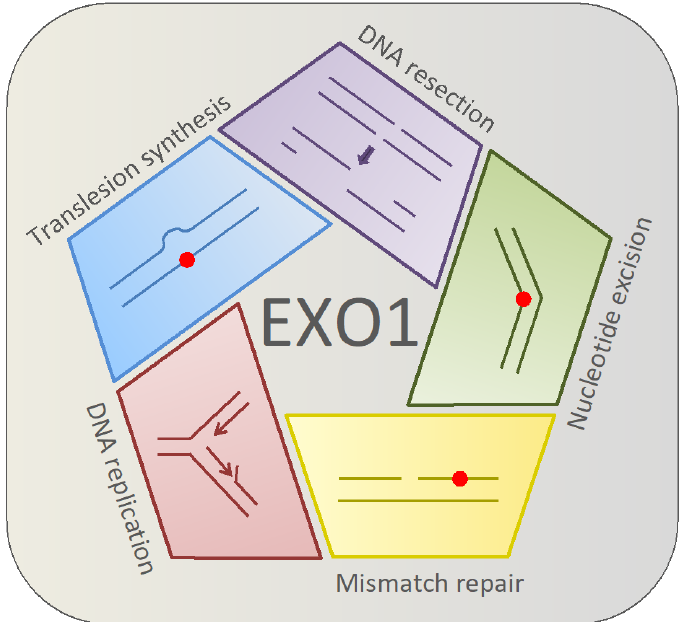
Figure 1. Human EXO1 participates in both replicative and post-replicative processes. In the replicative process, EXO1 contributes to DNA replication by assisting in the removal of mismatches, bypassing the lesion using translesion synthesis, or by assisting with nucleotide excision repair by activating the NER repair pathway. EXO1 also has a role in DNA resection during the process of homologous recombination.